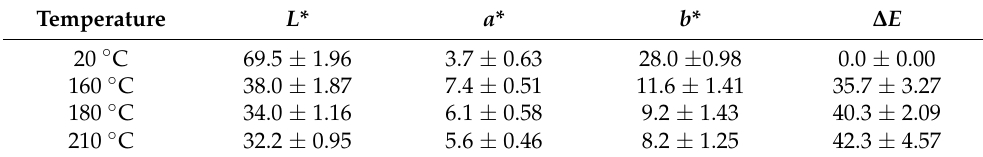
The measured colour data were visualized with the proposed method of Hrˇcka [41] (Figure 2). The brown crosses represent the measured data in CIE L * a * b * colour space. The black and RGB ellipses are projections of data clouds to CIE L * a * b * planes. The black ellipses represent the colour of unmodified samples (20 ◦ C). The red ellipses represent the colour of modified samples at 160 ◦ C. The green ellipses represent the colour of modified samples at 180 ◦ C. The blue ellipses represent the colour of modified samples at 210 ◦ C. The alpha level of 0.1% was selected, because of the large variability of wood colour data. Despite the alpha-level low value, the observed lightness of modified wood decreased